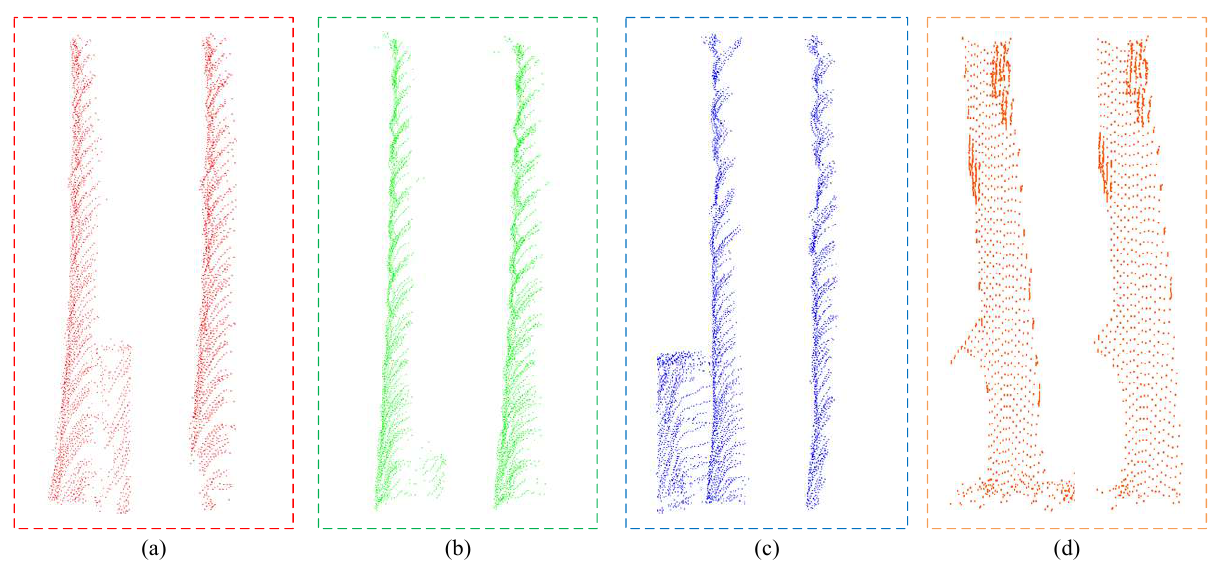
Figure 17. Denoising results: Comparison of four trunks denoising before and after. The left side of ( a – d ) is before denoising and the right side is after denoising.